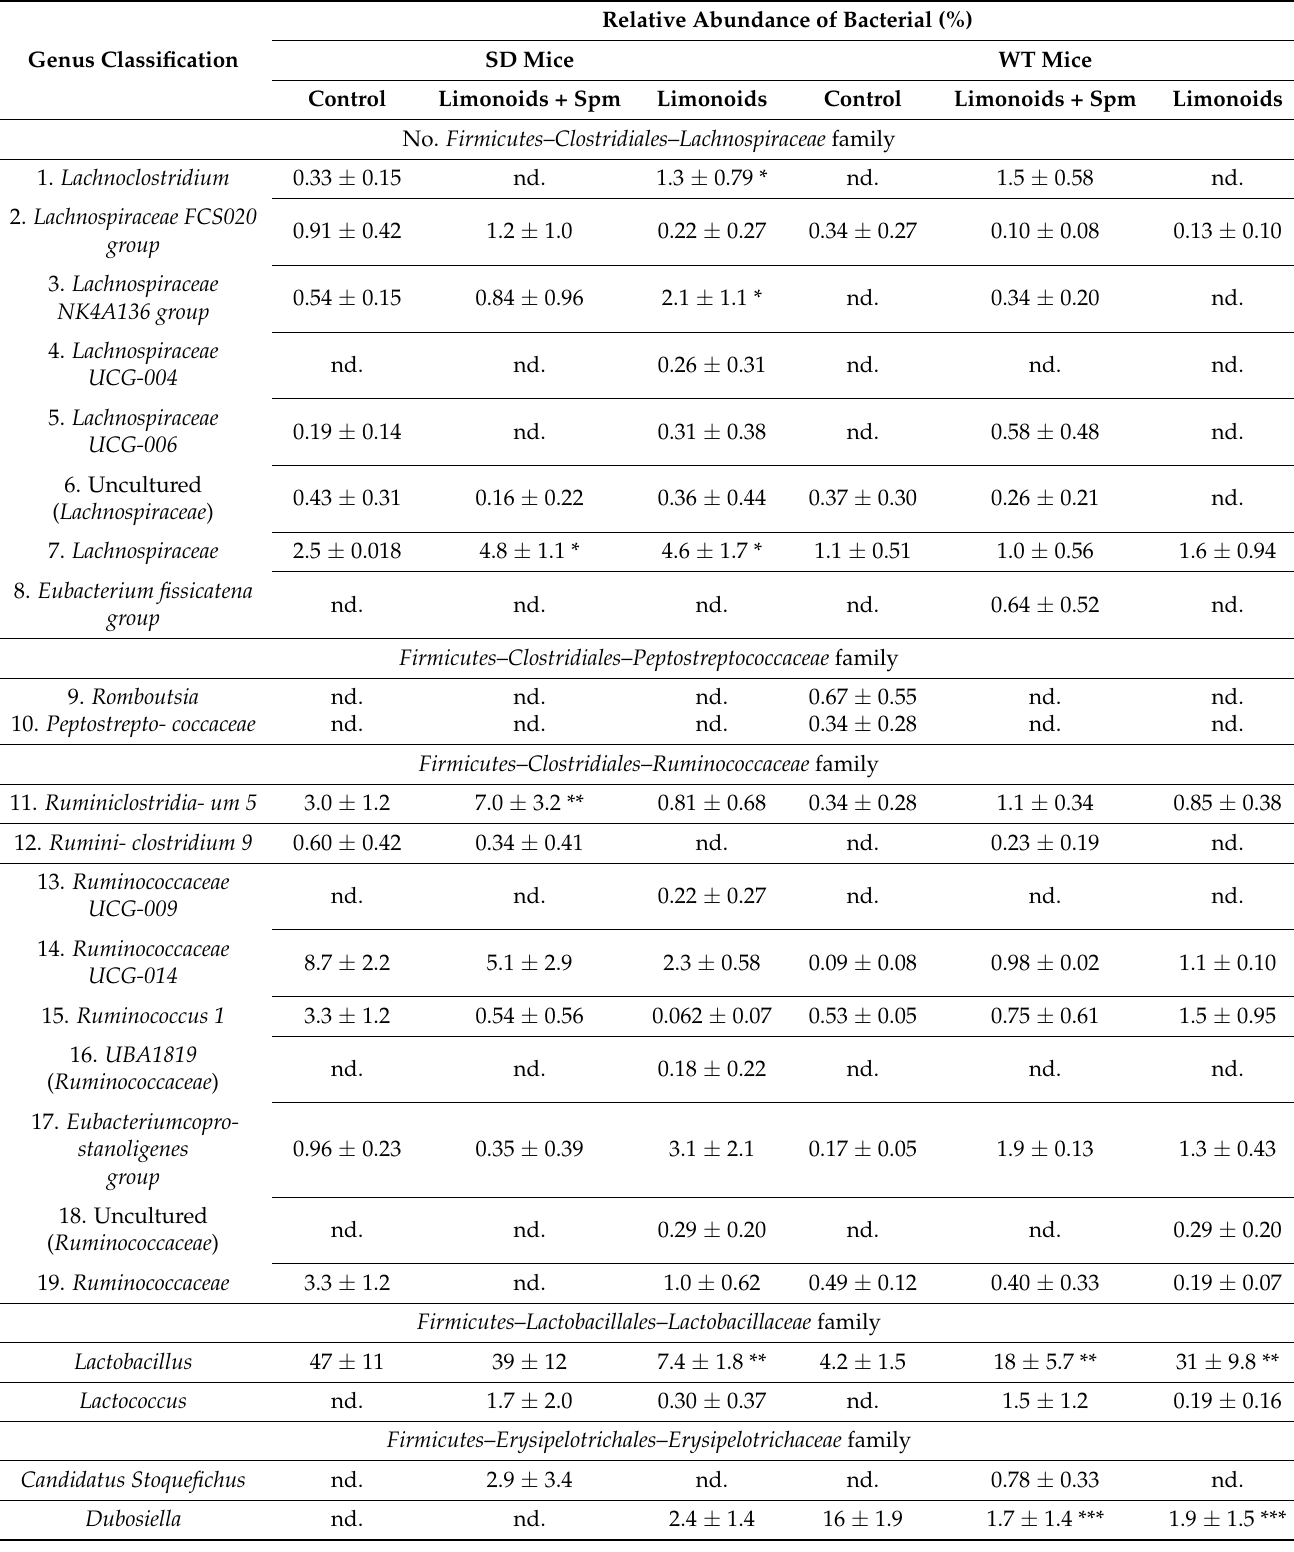
Table 1. Comparison of the relative abundance of bacterial (%) in feces from SD or WT mice fed with a normal diet (control), limonoids + Spm or limonoids